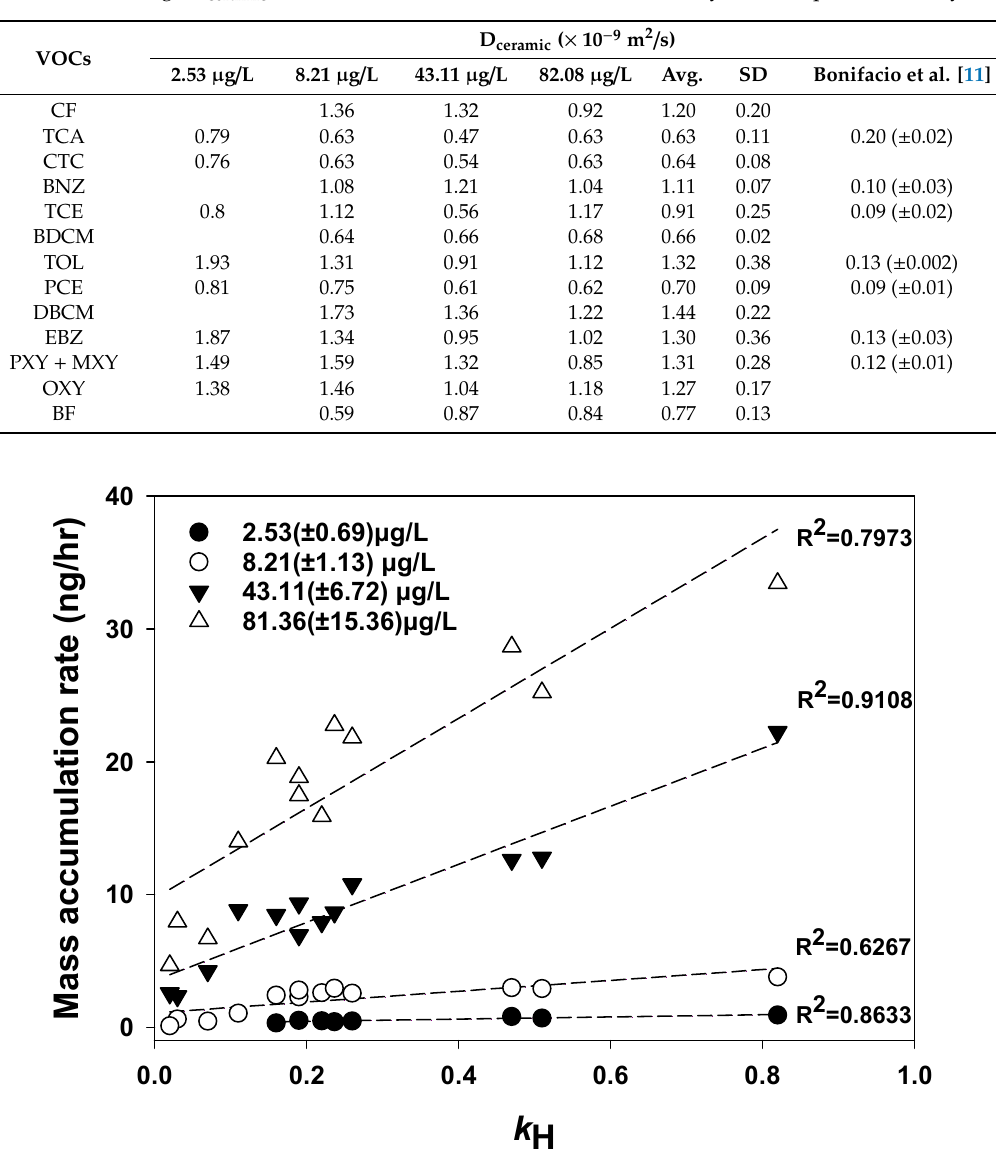
Figure 3. Correlation between the Henry’s law constant (k H at 20 ◦ C) and the VOC mass accumulation rate in the solid ceramic